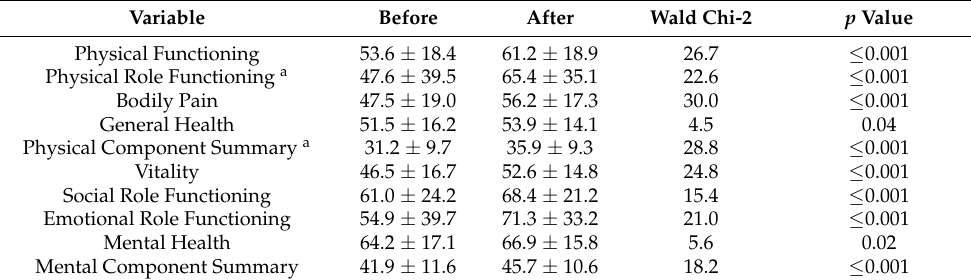
Table 3. Short-Form 36 scores before and after the supervised exercise training program.